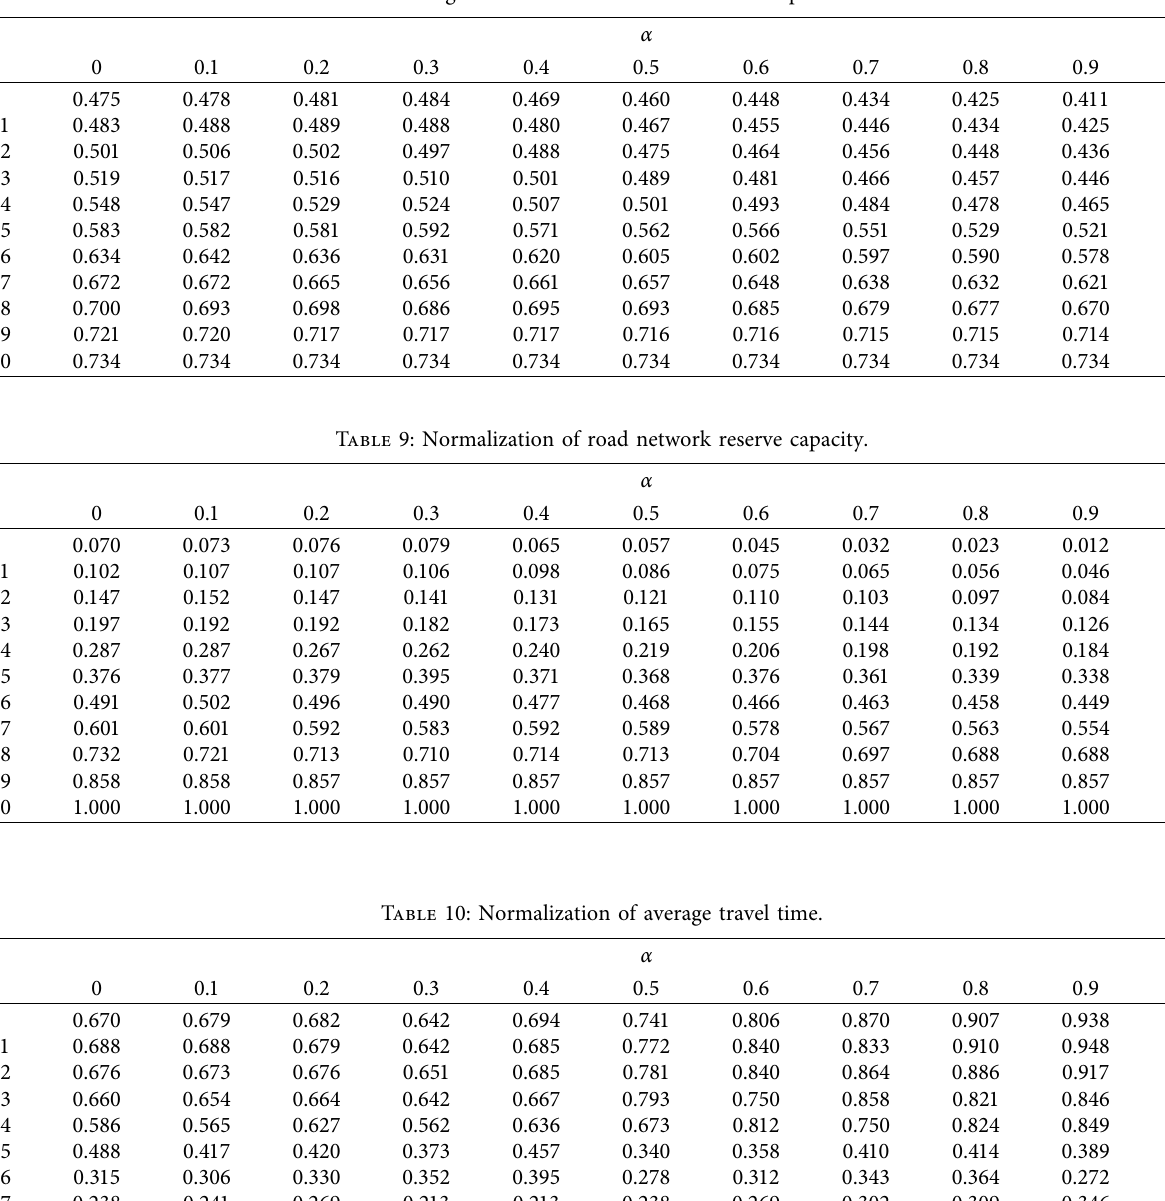
Table 8: Average saturation under different market penetration.